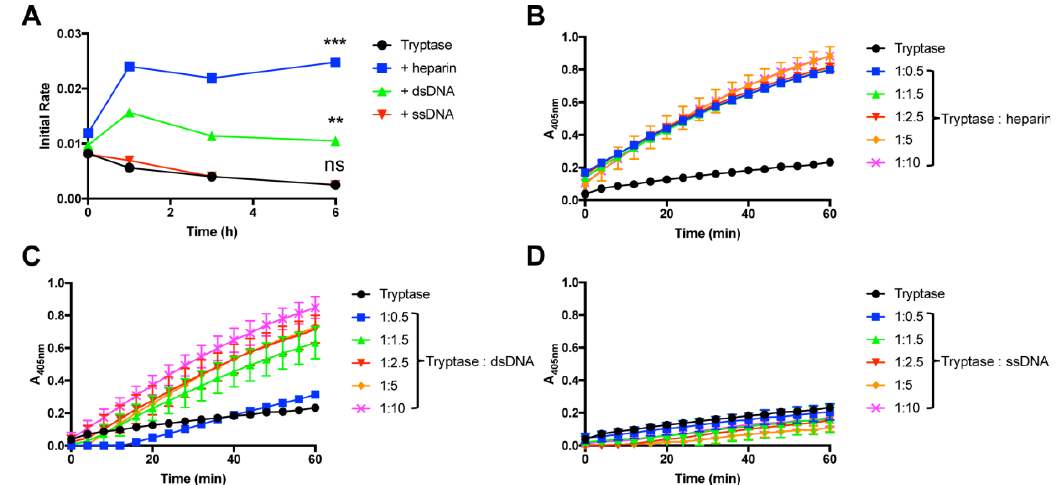
Figure 1. DNA stabilizes tryptase activity at room temperature. ( A ) β -tryptase (0.7 ng/µL in PBS, pH 7.2) was incubated at room temperature either alone or in the presence of either heparin, dsDNA or ssDNA (ratio 1:5) at the time periods indicated. Residual tryptase activity was then measured using the chromogenic substrate S-2288. ( B – D ) Dose response experiments for β -tryptase (0.7 ng/µL; in PBS, pH 7.2) after incubation for 3 h at room temperature, in the absence or presence of either heparin ( B ), dsDNA ( C ) or ssDNA ( D ) at the indicated concentrations. Residual tryptase activity was then measured using the chromogenic substrate S-2288. The data are representative of at least 3 individual experiments. Data are given as mean values ± SD ( n = 3) ***, p ≤ 0.001 **, p ≤ 0.01; ns, not significant (One-way ANOVA).